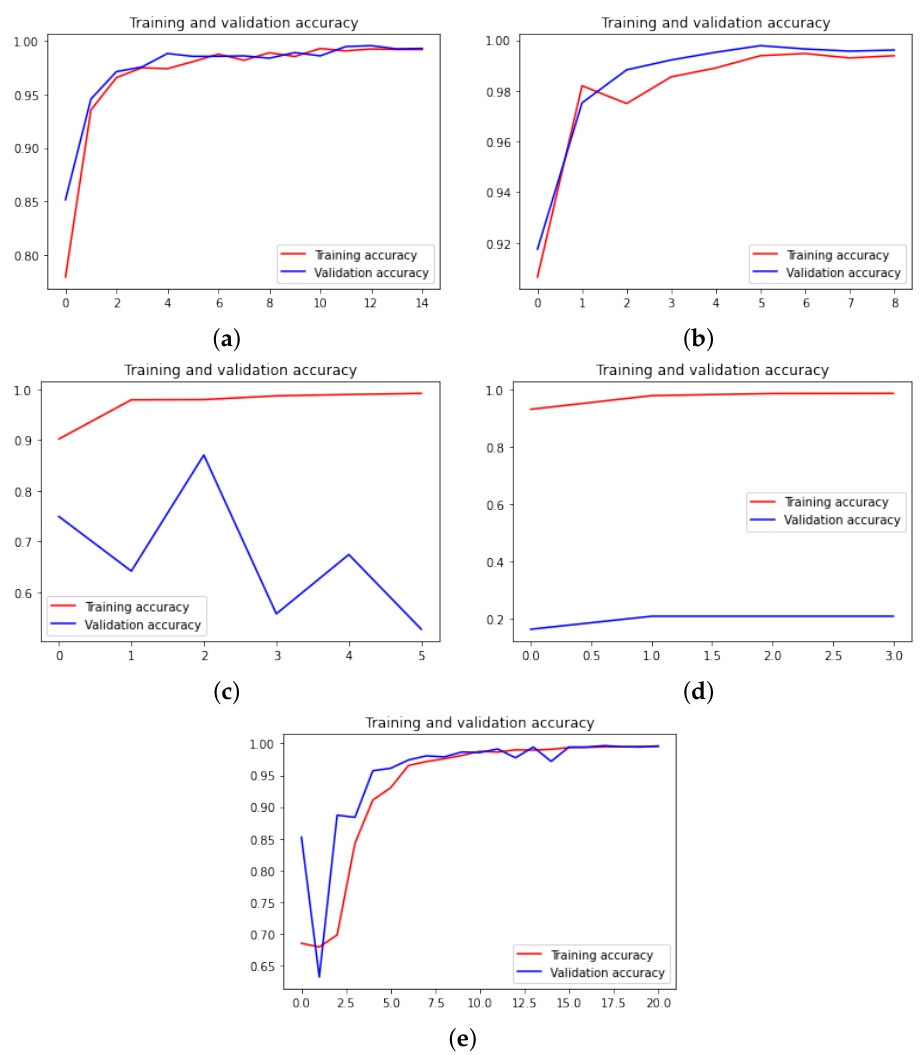
Figure 8. Accuracy curves for the human reticulocyte dataset. ( a ) Xception. ( b ) DensNet. ( c ) MobileNet. ( d ) ResNet. ( e )